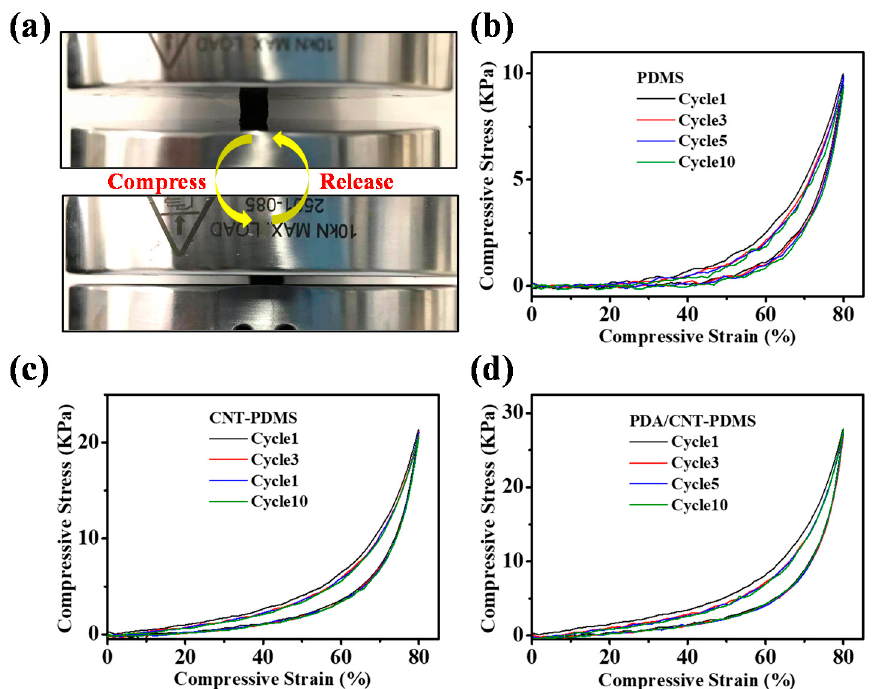
Figure 4. ( a ) Digital images of a uniaxial compressive test cycle. Compressive stress–strain curves of PDMS ( b ), CNT-PDMS ( c ), and PDA/CNT-PDMS ( d ) sponges at the maximum strain of 80% for 10 cycles.